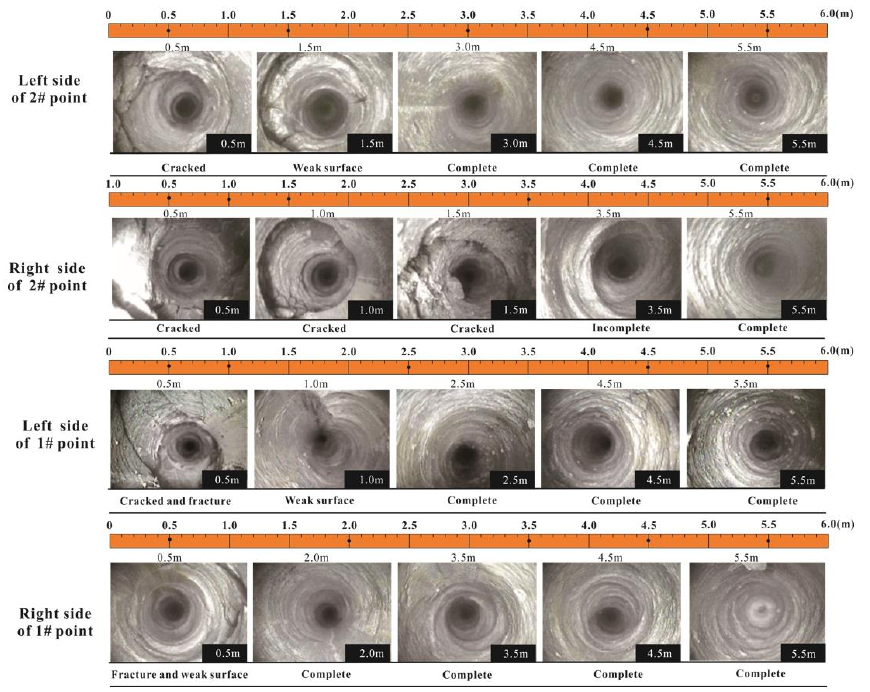
Figure 6. Borehole peep imaging.